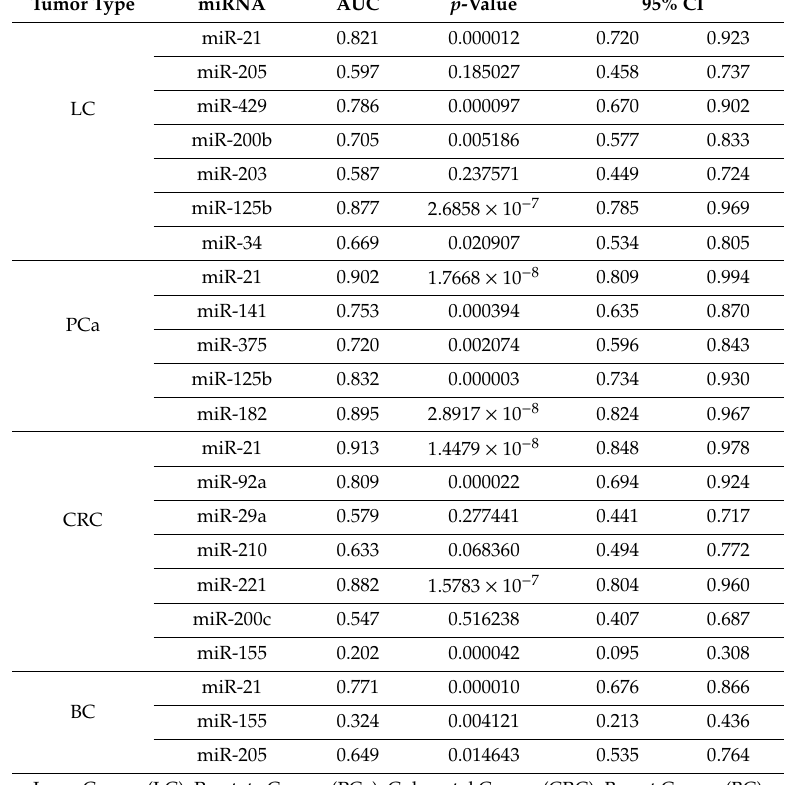
Table 1. Results of the ROC curve analysis: Summary of the results for each of the selected miRNAs according to tumor